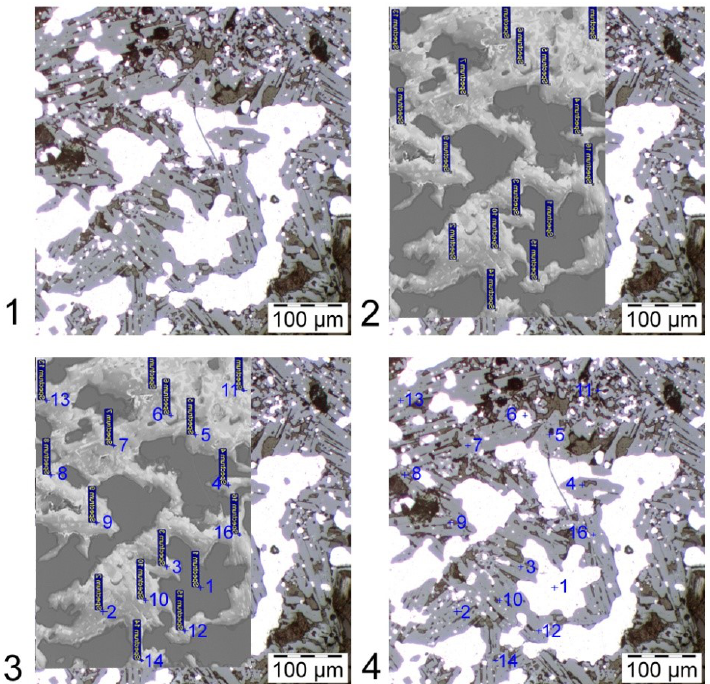
Figure 1. Transfer of analysis points from a scanning electron microscopy (SEM) image to a light optical microscopy (LOM) image, where 4 represents the final result. (1) Original LOM image, (2) Overlay of SEM image on top of LOM image, (3) Mapping SEM measurement points to LOM image and (4) LOM image with SEM measurement